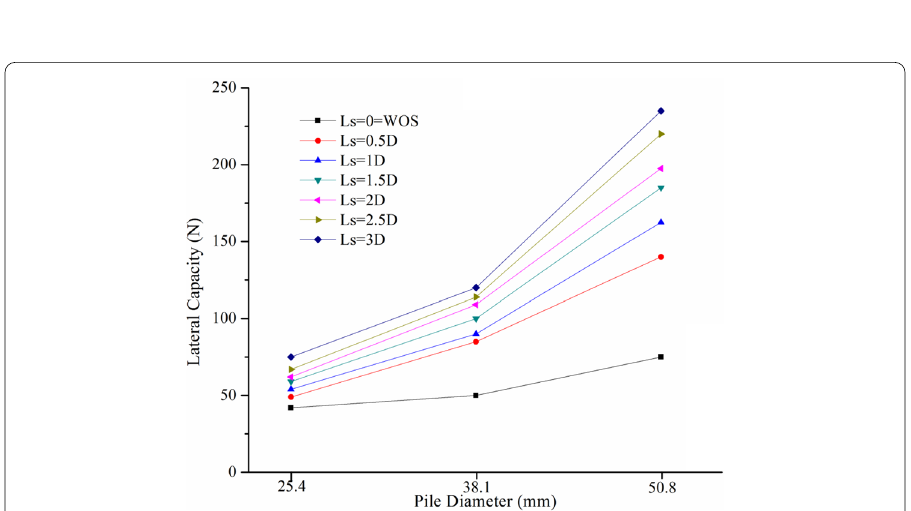
Fig. 10 Lateral capacity of pile with varying depth of socketing for pile having embedded depth L e 600 mm